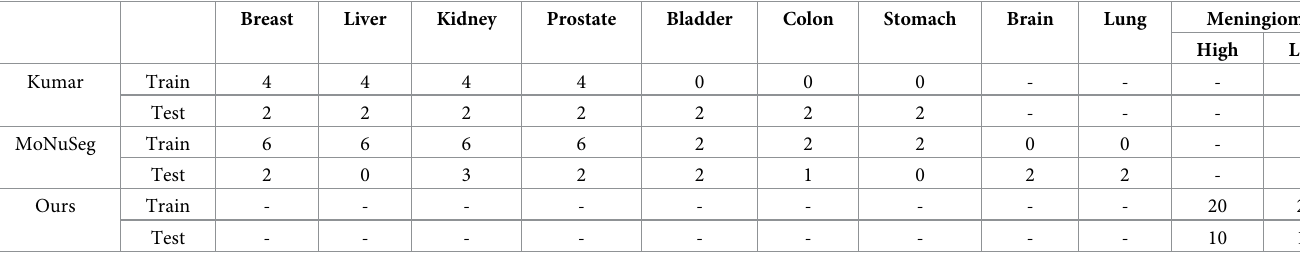
Table 1. Sample images from multiple datasets for image